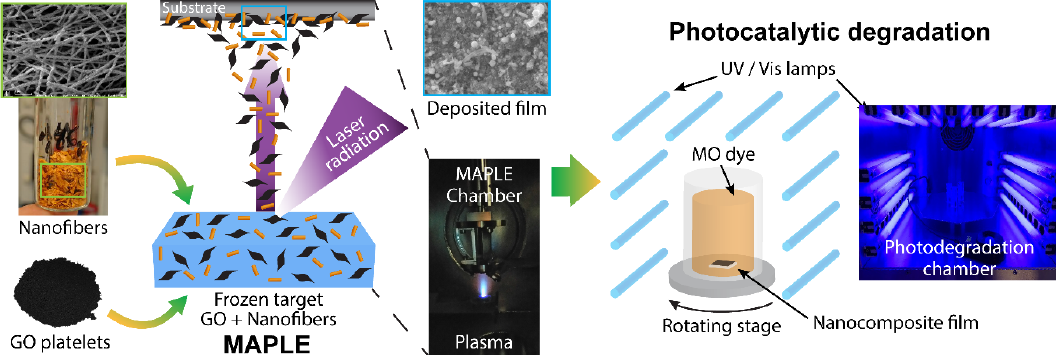
Figure 1. Schematic representation of the experimental MAPLE approach used for the fabrication of GO/MFO nanofiber films, as well as the photodegradation